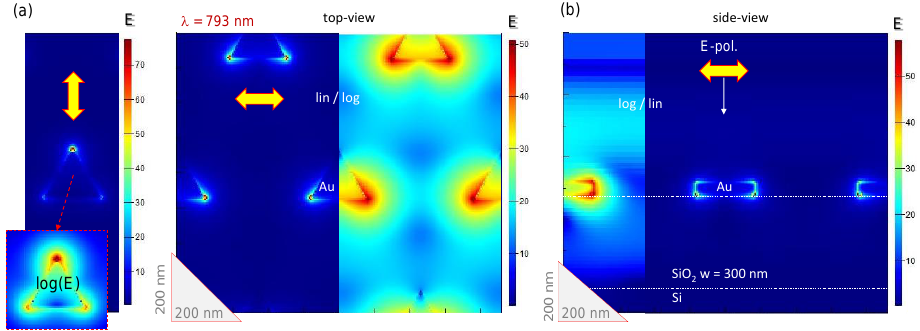
Figure 5. ( a ) Top view FDTD calculations at the maximum E-field enhancement for L = 180 nm and w = 300 nm (see Figure 4) for both E y and E x polarisations. The top-view monitor is at the air-SiO 2 interface and the side-view monitor crosses the side of triangle and vertexes with the highest field enhancement. The E-field scale bars are linear; polarisation of incident field was horizontal E x . Larger enhancement for E y orientation as compared with E x is manifested in corresponding scaling of SHG (See Figure 3). Calculations for the two E x , y ( ω ) fields were carried out for the same unit cell. ( b ) Side view cross section for the E x